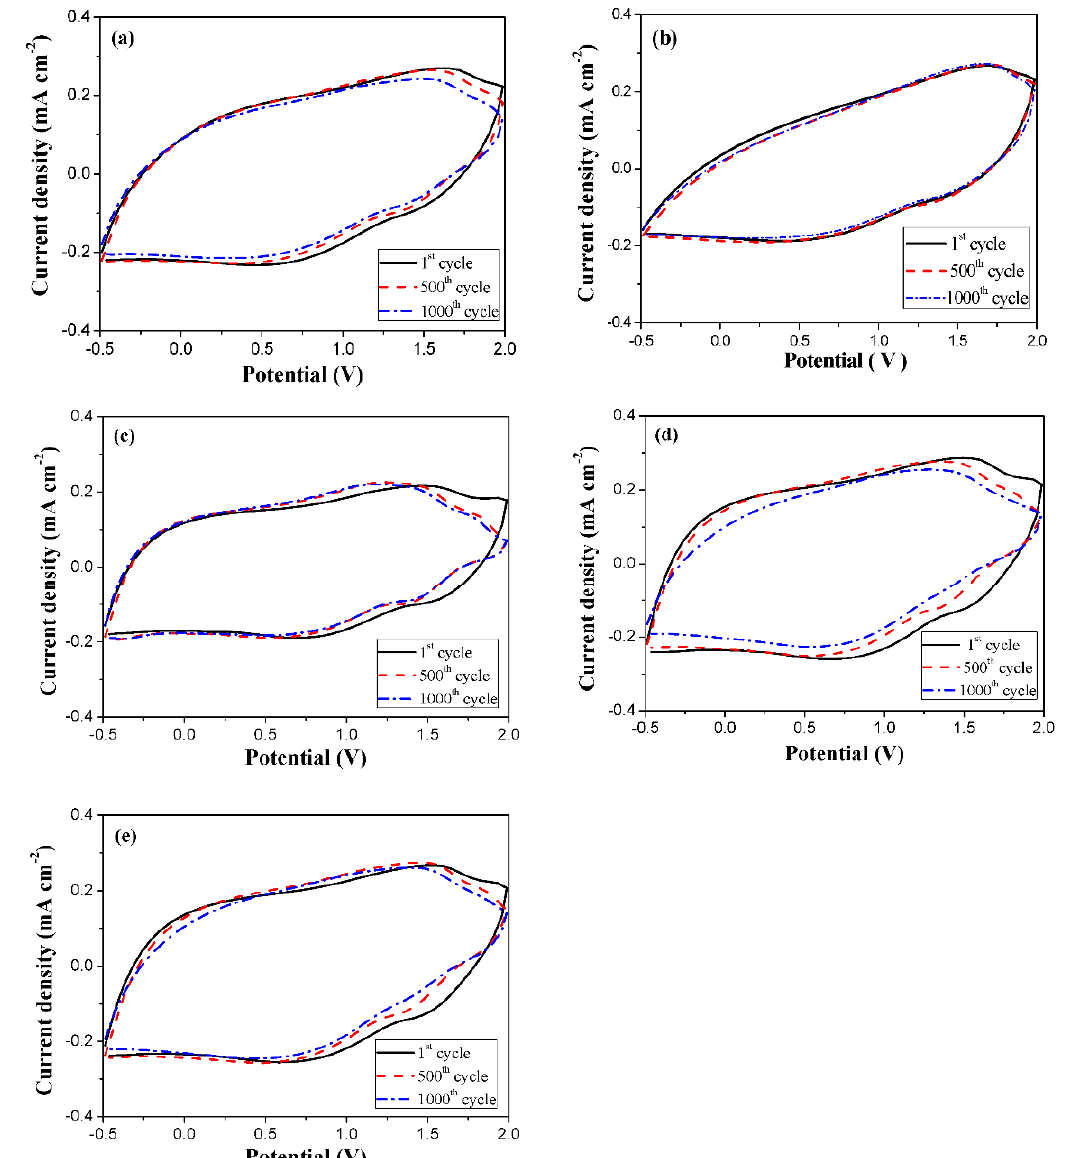
Figure 9. CV curves of the ( a ) P(DCB)/PEDOT-PSS, ( b ) P(DCB- co -ED)/PEDOT-PSS, ( c ) P(2DCB- co - ED)/PEDOT-PSS, ( d ) P(DCB- co -EDm)/PEDOT-PSS and ( e ) P(2DCB- co -EDm)/PEDOT-PSS devices.